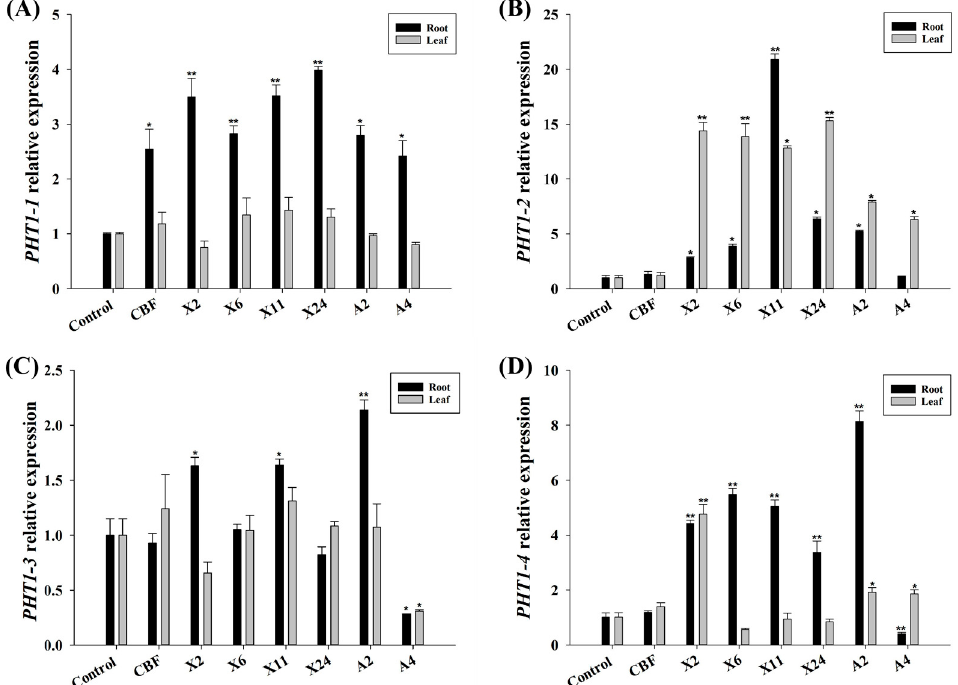
Figure 5. Effect of selected fungi inoculations on the relative expression levels of ( A ) PHT1-1 , ( B ) PHT1-2 , ( C ) PHT1-3 , and ( D ) PHT1-4 genes in blueberry seedling roots and leaves. Control plants were treated with conventional organic fertilizer with nutrient solution, CBF was treated with commercial bacterial fertilizer, and the remaining treatments were treated with conventional organic fertilizer with nutrient solution, then inoculated with beneficial endomycorrhizal fungi isolates. Asterisks indicate significant differences between groups (* p < 0.05, ** p < 0.01). Error bars represent the standard error of means ( n = 3).